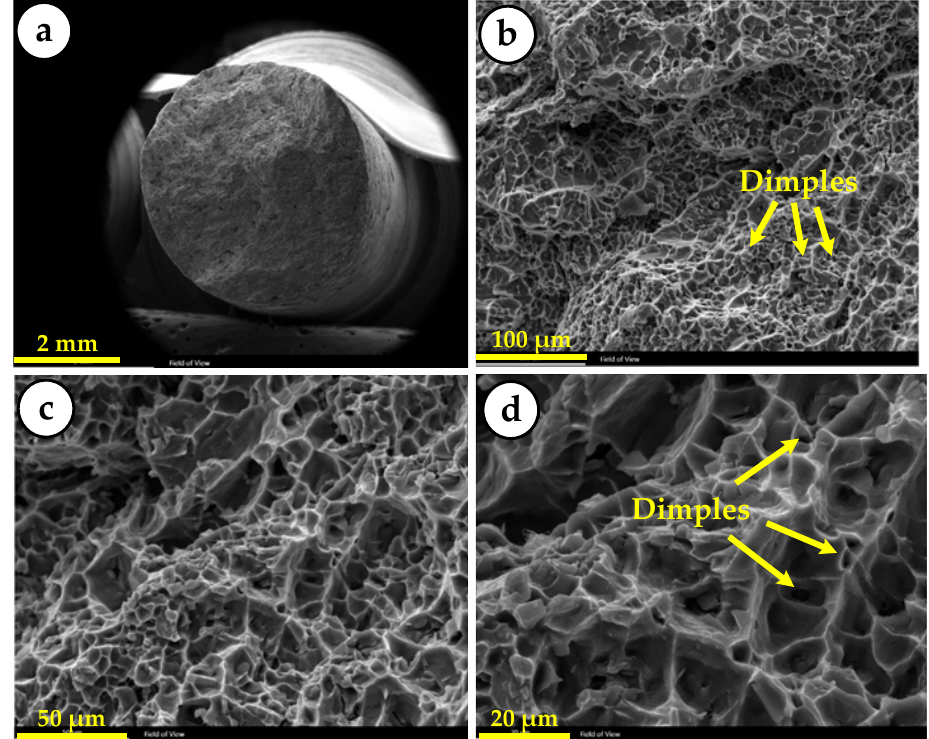
Figure 8. SEM micrographs of the fractured surface of COMP0, ( a ), at different scales of 100 µm ( b ), 50 µm ( c ), and 20 µm ( d ).